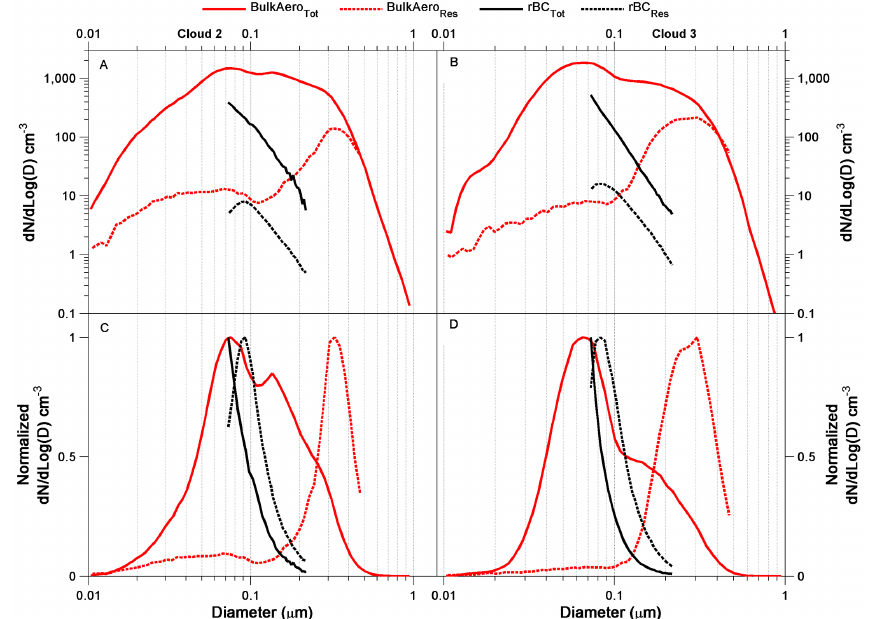
Figure 5. Summary of the averaged number size distributions for Cloud 2 (a, c) and Cloud 3 (b, d) for the total aerosol (red solid lines); residual aerosol (red dashed lines); total rBC as a function of core diameter (black solid lines); residual rBC as a function of core diameter (black dashed lines). Both the aerosol and rBC for each cloud event are shown in two ways: a log scale (a, b) to highlight the relative differ- ences between the aerosol and rBC as well as normalized to the respective maximum value (c, d) to highlight the shift in size distributions. All residual distributions have been corrected for instrument sensitivity (Fig. S1), CVI enhancement (Sect. S1), and droplet losses (Sect.